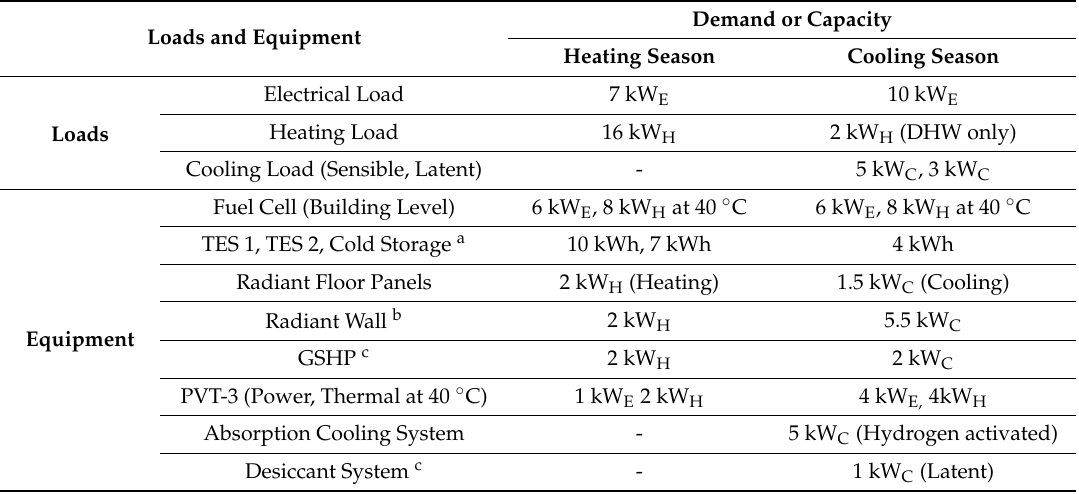
Table 5. Typical Building Level Data for the Hydrogen City Model.